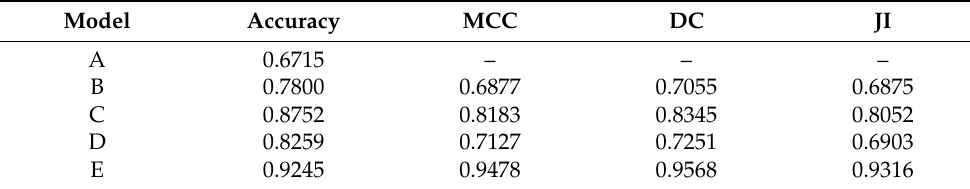
Table 2. Performance metrics of the U-Net when evaluating the images from the test set with the different trained models used to assess the training